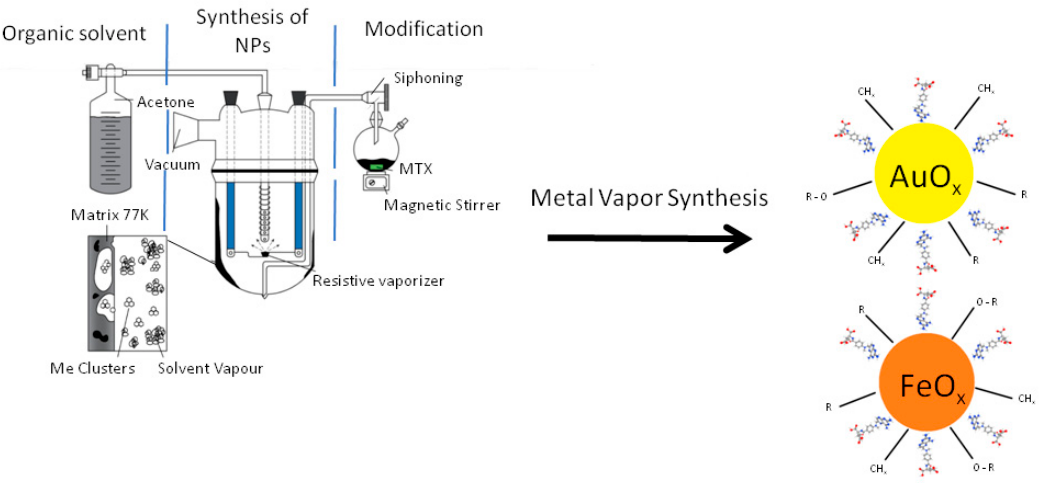
Figure 1. Scheme of synthesis of metal nanoparticles modified with methotrexate.